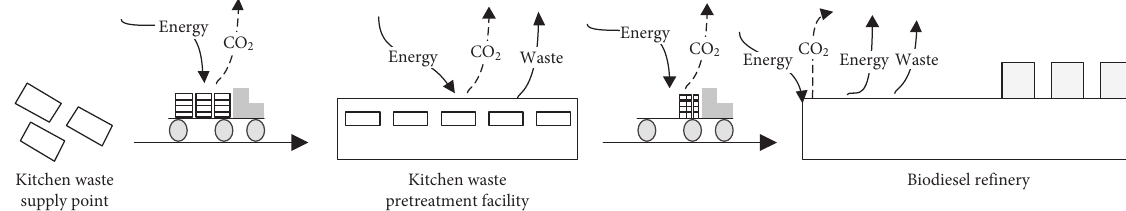
Figure 1: Waste cooking oil for biodiesel supply